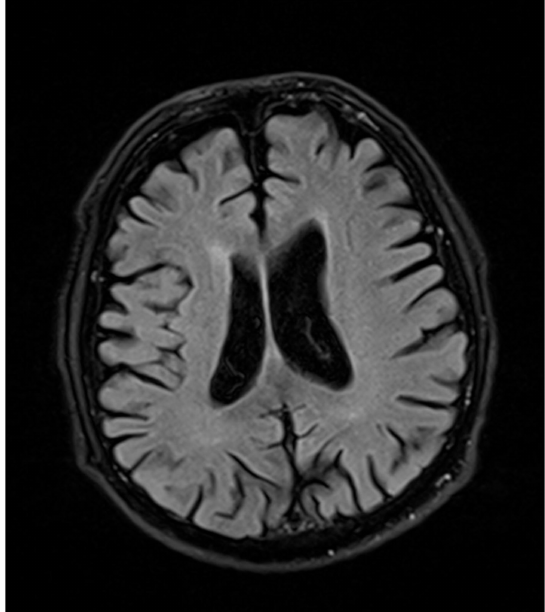
Figure 1. Magnetic resonance (MR) examination of the head performed two years before patient’s death. The cortical and subcortical atrophy is marked.